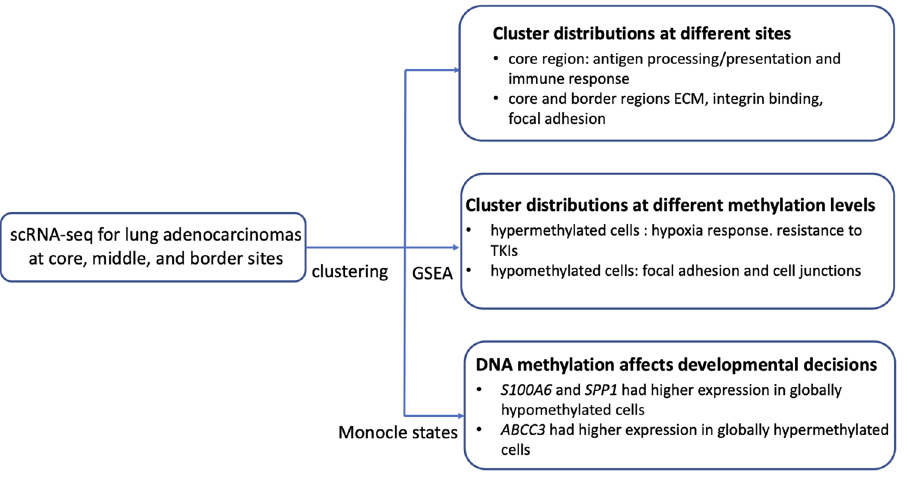
Figure 1. Flowchart showing the analysis pipeline and main findings.